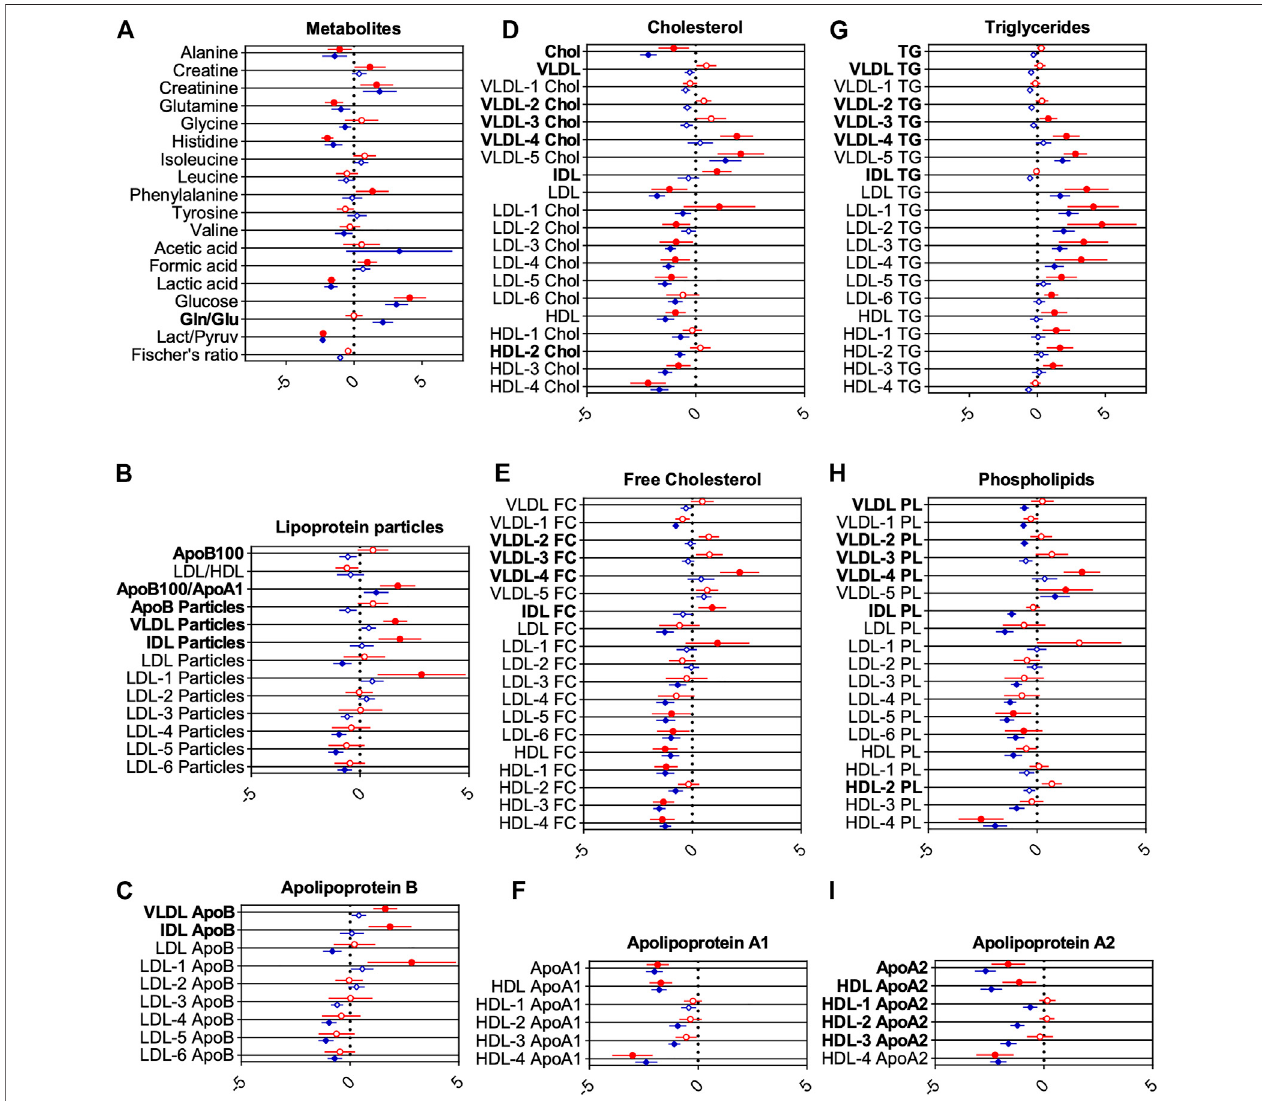
FIGURE 4| Forest plots showing changes for groups of metabolites (A) and lipoprotein classes (B-I) . Middle lineindicates reference average, whereas circles and diamonds on horizontal axes show changes scaled by standard deviations. Red circles show changes for COVID-19 samples, blue circles for CS, both with healthy controls as reference (vertical line). Statistically signi fi cant differences between CS and COVID-19 to HC determined using false discovery method of Benjamini, Krieger, and Yekutieli (Q (cid:1) 1%) are indicated by fi lled circles or diamonds. Letters printed in bold indicate metabolites and lipoproteins, which are signi fi cantly changed between COVID-19 and